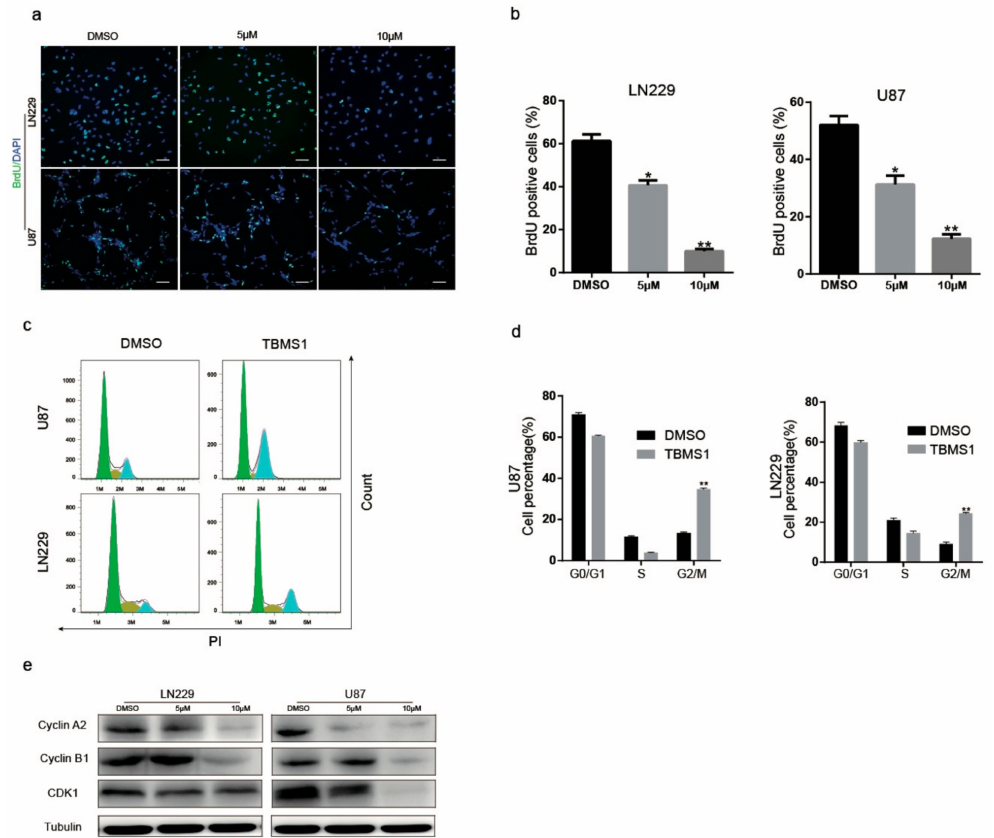
Figure 2. TBMS1 causes glioblastoma cells cell cycle arrest at G2 phase. ( a ) Changes in the number of BrdU-positive cells in LN229 and U87 cells treated with di ff erent concentrations of TBMS1 for 48 h. DMSO was added as a control, scale bar was 200 µ m. ( b ) A statistical plot of the BrdU positive cell rate in panel ( a ). ( c ) Cell cycle detection of LN229 and U87 cells supplemented with DMSO or TMBS1 was performed by flow cytometry. ( d ) The graph of the percentage of the results of each cycle of the cells is statistically plotted in the graph ( c ). ( e ) The protein expression levels of CDK1, Cyclin A2, Cyclin B1 and Tubulin in LN229 and U87 cells treated with di ff erent concentrations of TBMS1 for 48 h. DMSO was added as a control. * p < 0.05, ** p < 0.01, *** p < 0.001, p -values < 0.05 were considered as statistically